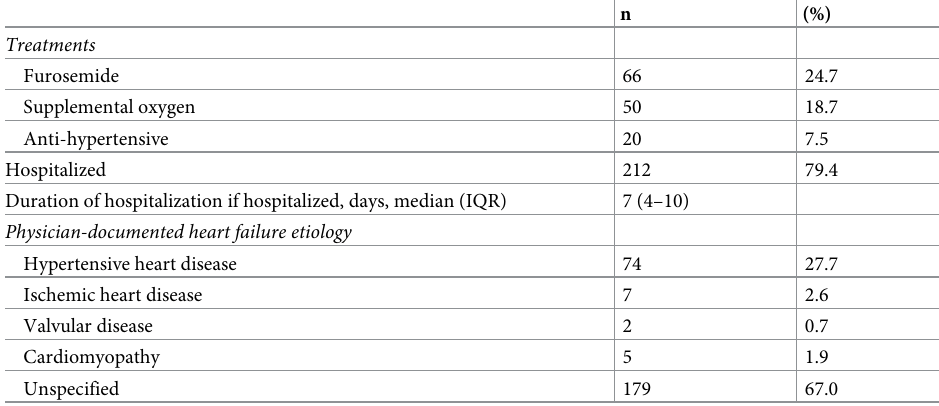
Table 2. Emergency department care for adult patients diagnosed with heart failure, northern Tanzania, 2018– 2019, (n = 267).